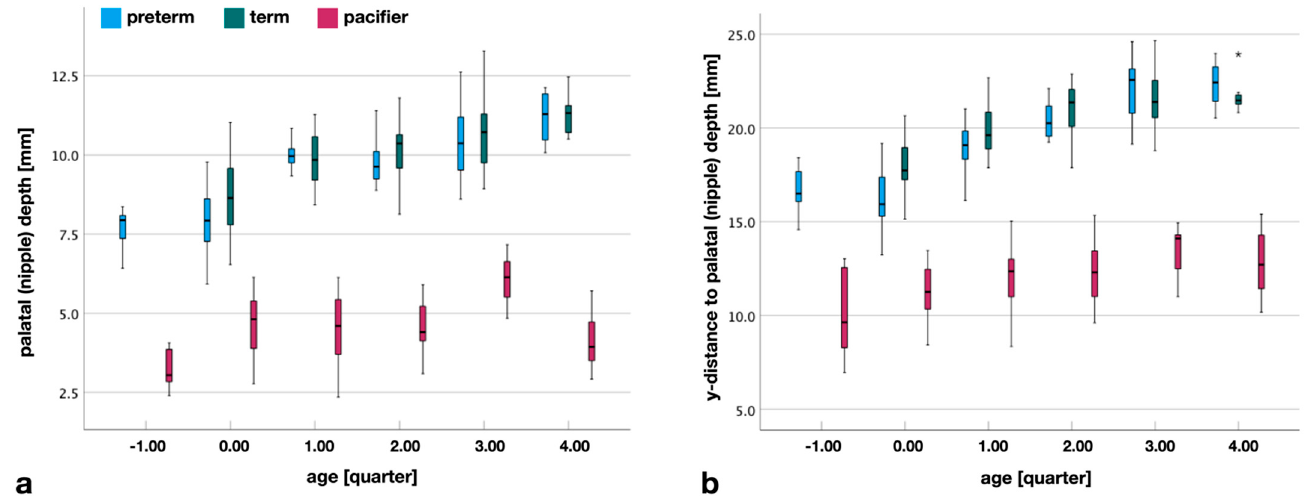
Figure 5. ( a ) Palatal depth (pd) and artificial nipple depth ( npd ). Distance in vertical (z-) direction between ARP and the deepest point of the palate (preterm, term) as well as the highest point of the artificial nipple. Compared to the infants’ palates, the pacifiers do not show any increase in size, in terms of a growth effect. ( b ) Location of the deepest point of the palate and the highest point of the artificial nipple. Distance in the horizontal (y-) direction from the anteriormost to the deepest part of the palate (preterm, term) and from the lip shield plane to the highest point of the artificial nipple minus lip thickness (pacifier). (*) extreme